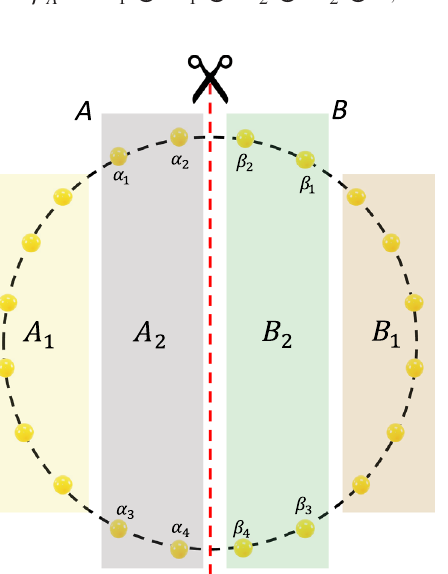
FIG. 8. A sketch for analytically computing the entanglement entropy and spectrum of the 1D symmetry-protected-topological cluster state, through the corresponding exact short-range re- stricted-Boltzmann-machine representation. The scissors show a cut of the system into two subsystems A and B . We calculate the entanglement entropy and spectrum from the reduced density matrix ρ A . In order to conveniently explore the short-range feature of the restricted-Boltzmann machine, we further divide A ( B ) into A A B B Γ 1 and 2 ( 1 and 2 ). It is important that the k 0 factors in subregion A 1 ( B 1 ) are independent of spin configura- tions in B ( A ), such that the summations of spin configurations in A 1 and B 1 are interchangeable and can be factorized out explicitly, as shown in Eq.